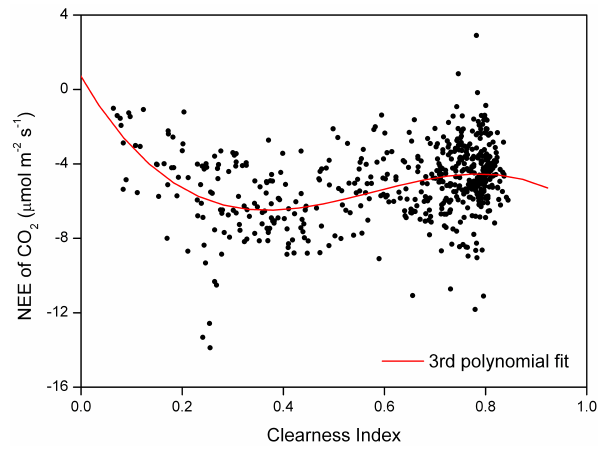
Fig. 3. Relationship of 3rd polynomial fit ( n = 540, r 2 = 0 . 15, p < 0 . 01) between 30-min averaged NEE and clearness index.